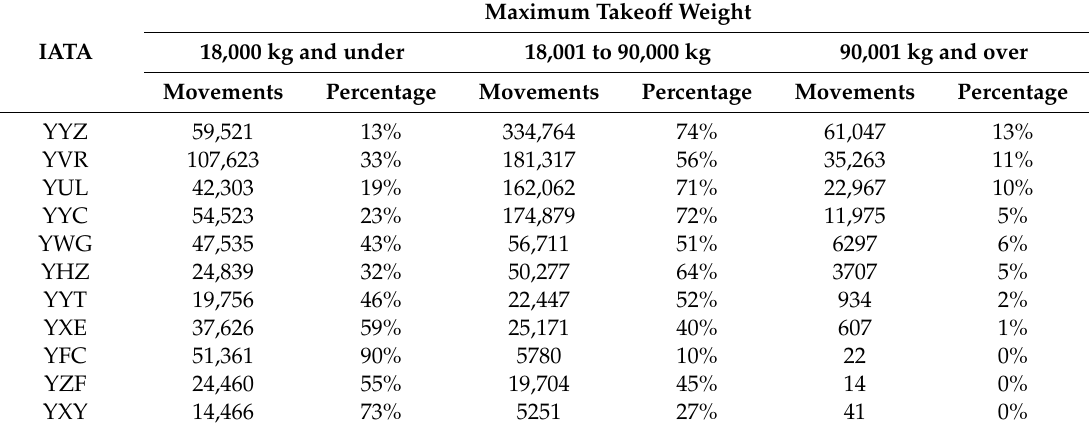
Table 2. Average annual itinerant movements (i.e., takeo ff and landing) for the 2014–2018 period for three categories of aircrafts from Statistics Canada [38] (from busiest to least busy). Itinerant movements, expressed as percentage of total movements, are also included. Data for Iqaluit Airport and Charlottetown Airport was not